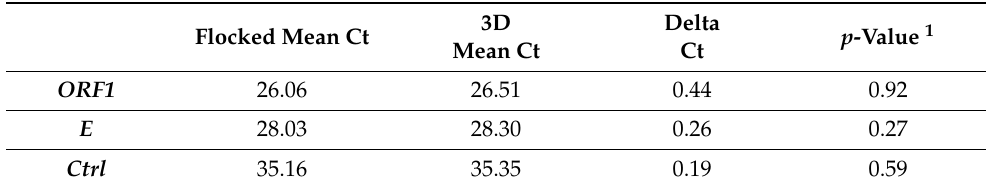
Figure 3. Cycle threshold (Ct) values of reverse-transcriptase polymerase chain reaction (RT-PCR) for the ORF1 and E genes. Participants were swabbed in the same nostril with a flocked and a 3D-printed swab, successively. RT-PCR was performed to measure the Ct values of ORF1 ( A ) and E ( B ) viral genes for each swab. An internal control (Ctrl) was also included ( C ). Statistical analyses are detailed in Table 1. Table 1. Mean Ct values of samples collected from individuals tested with a flocked or a 3D- printed